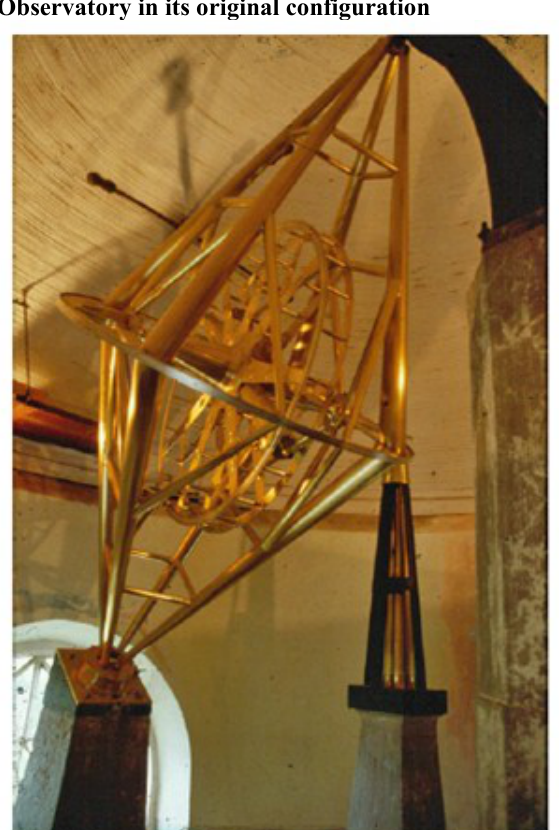
Figure 10: The Jones Mural Circle at Armagh Observatory in its original configuration